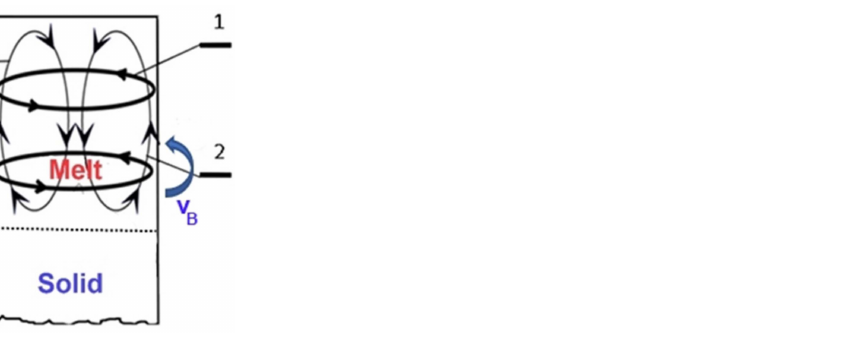
Figure 1. Melt flow developed by the RMF inductors. 1: primary flow, 2: secondary flow.